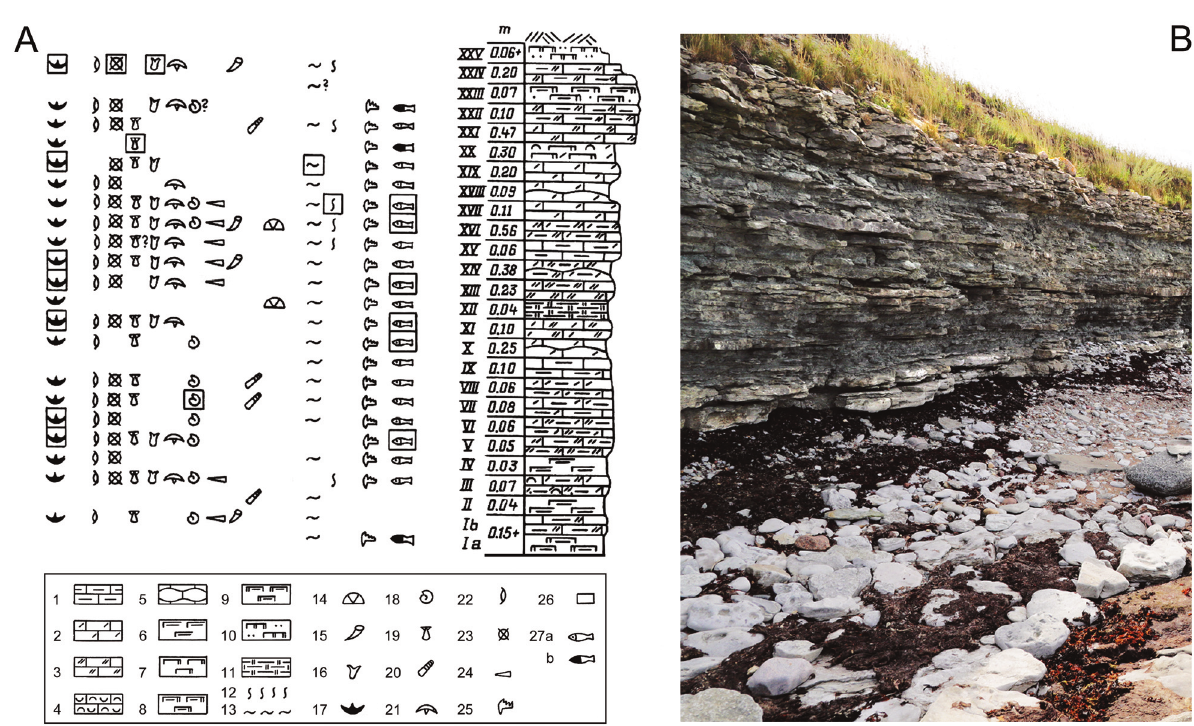
Fig. 1. Ohesaare Cliff, Saaremaa Island, Estonia. A , stratigraphic column (after Mark-Kurik et al. 1989, p. 33, Stop 7 fig., and explanation of figures); B , photograph of the cliff by TM. [Limestones: 1, argillaceous; 2, fine-skeletal; 3, coarse-skeletal; 4, biomorphous; 5, nodular. Mudstones: 6, argillaceous; 7, magnesian calcareous; 8, magnesian argillaceous; 9, calcitic argillaceous; 10, silty calcareous; 11, magnesian clay. Fossils: 12, vertical trace fossils; 13, horizontal trace fossils; 14, tabulate corals; 15, rugose corals; 16, bryozoans; 17, brachiopods; 18, gastropods; 19, bivalves; 20, nautiloids; 21, trilobites; 22, ostracodes; 23, echinoderms; 24, tentaculites; 25, conodonts; 26, fossils occurring in abundance; 27, fish remains: a – scales and fragments; b – articulated